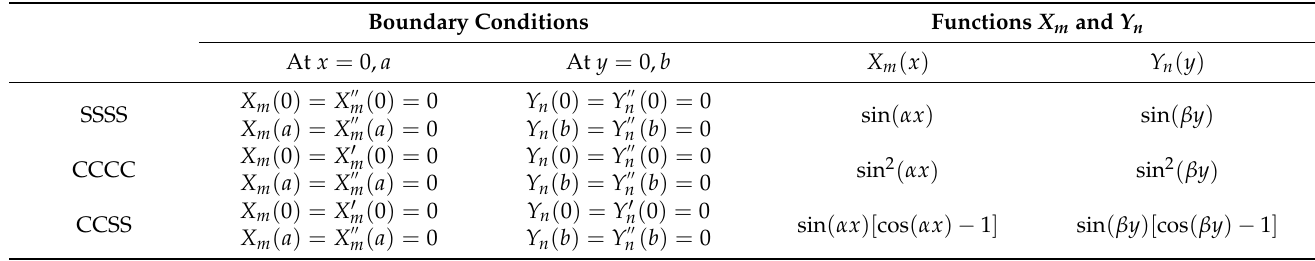
Table 1. The admissible functions X m ( x ) and Y n ( y ) for different boundary conditions. Boundary Conditions Functions X m and Y